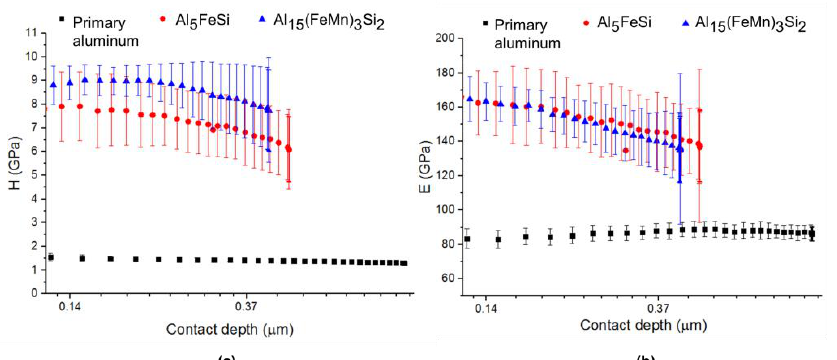
Figure 8. Instrumented nanoindentation analysis performed using the QCSM method, in A332 as-cast samples. Average of 10 indentations made with an indentation positioned at the center of the phase resulting in ( a ) hardness; ( b ) modulus of elasticity. values (a) (7.8 GPa in the Al 5 FeSi phase and 8.9 GPa in the Al 15 (FeMn)